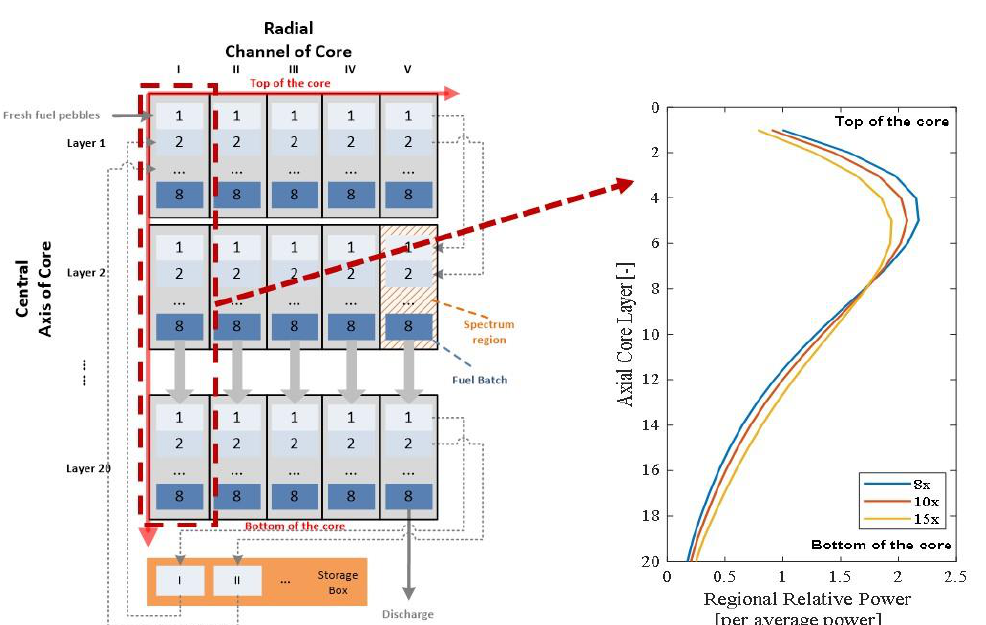
Figure 5. Regional relative power distribution alongside Channel I. Each spectrum region is mixed with different fuel batches corresponding to the adopted refueling times. Number of fuel batch is identical to refueling times.